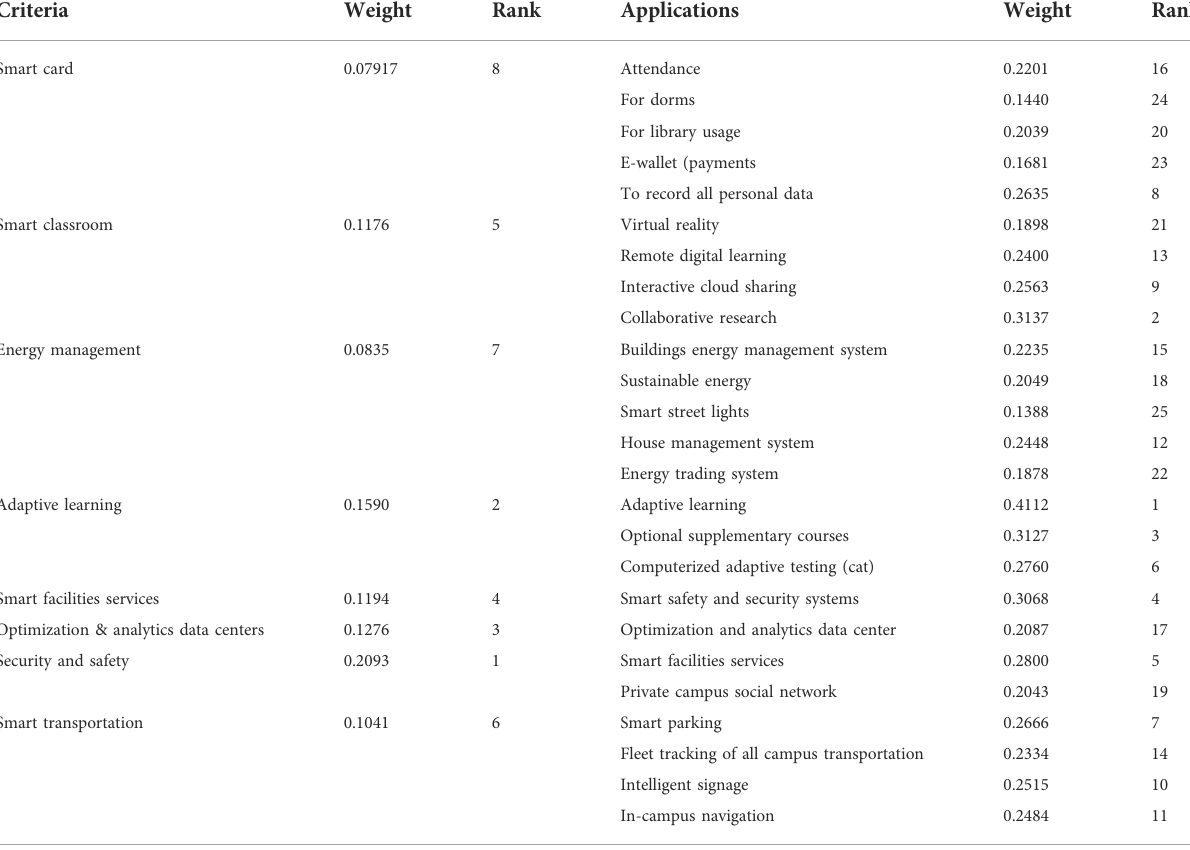
TABLE 4 Staff members ’ Perception regarding Signi fi cant Smart Campus Criteria.